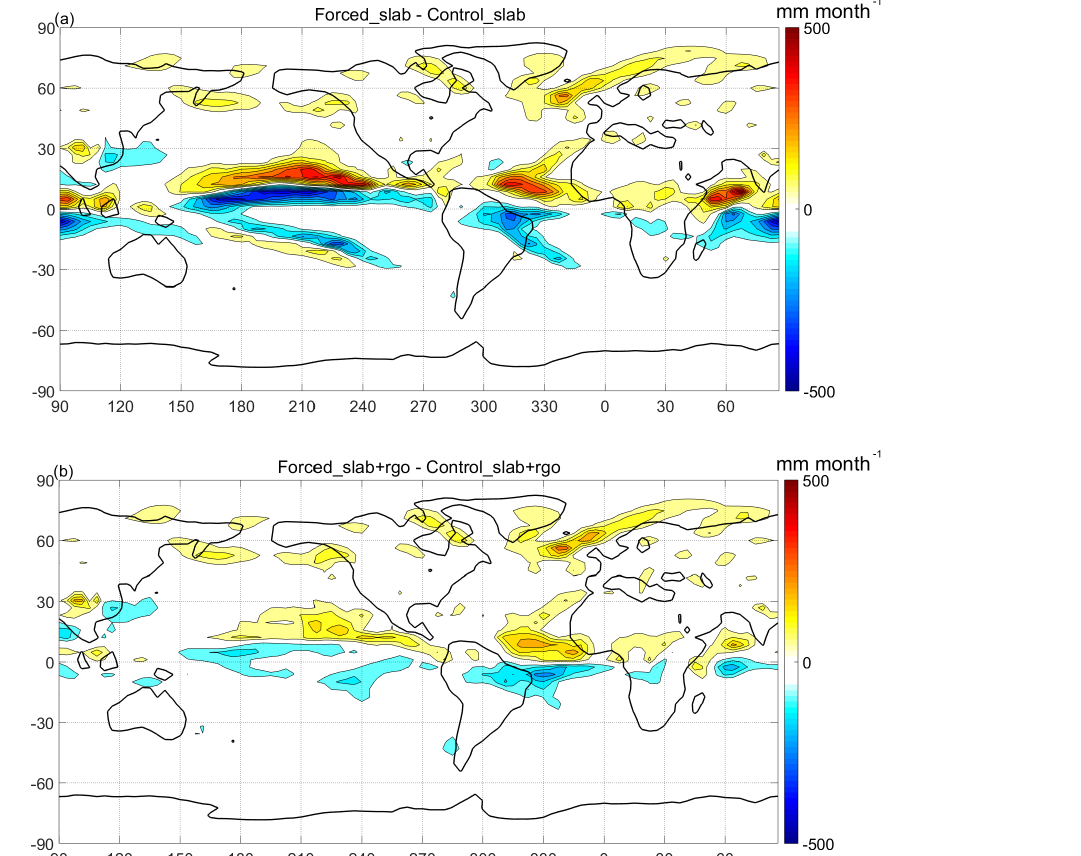
Figure 5. Annual mean anomalies with respect to the control of precipitation for (a) Forced_slab and (b) Forced_slab + rgo . Contour interval 50mmmonth − 1